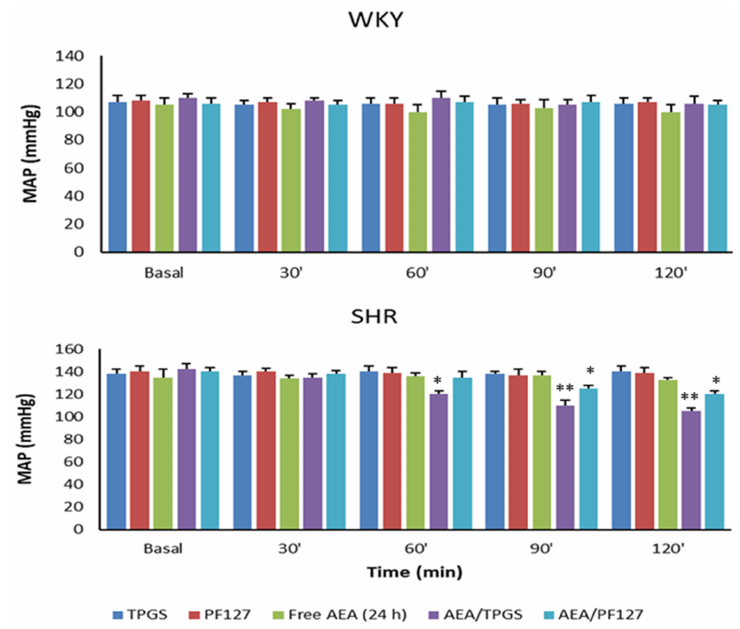
Figure 7. Mean arterial pressure, measured in WKY and SHR rats at basal conditions (control), as well as at 30, 60, 90, and 120 min after injection with different treatments: TPGS empty micelles (TPGS), PF127 empty micelles (PF127), AEA non-encapsulated 24 h after its dispersion in an aqueous solution (free AEA, 24 h), AEA/TPGS micelles (AEA/TPGS), AEA/PF127 micelles (AEA/PF127). n = 3. * p < 0.05; ** p < 0.01, all versus basal.